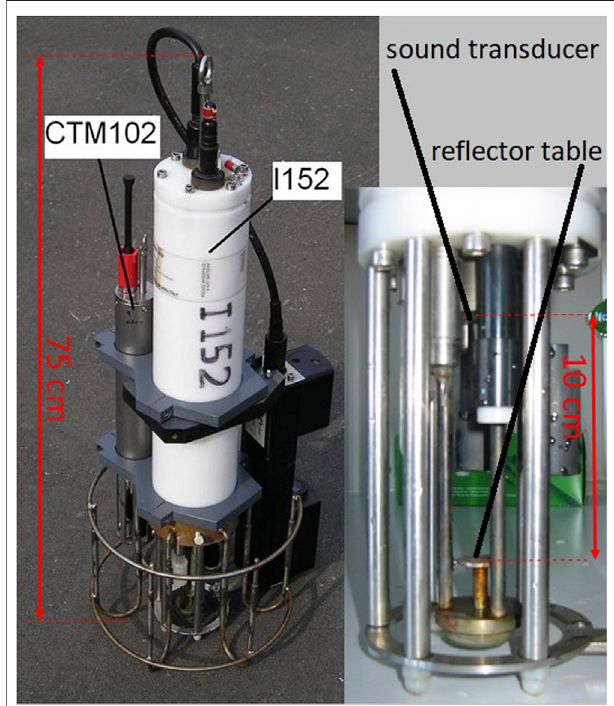
FIGURE 1 | The deployed multiparameter probe Idronaut Ocean Seven 316 “ I152 ” withtheVALEPORTsound speedsensormountedtogetherwitha faster CTD probe “ CTM102 ” (Sea and Sun Technology,